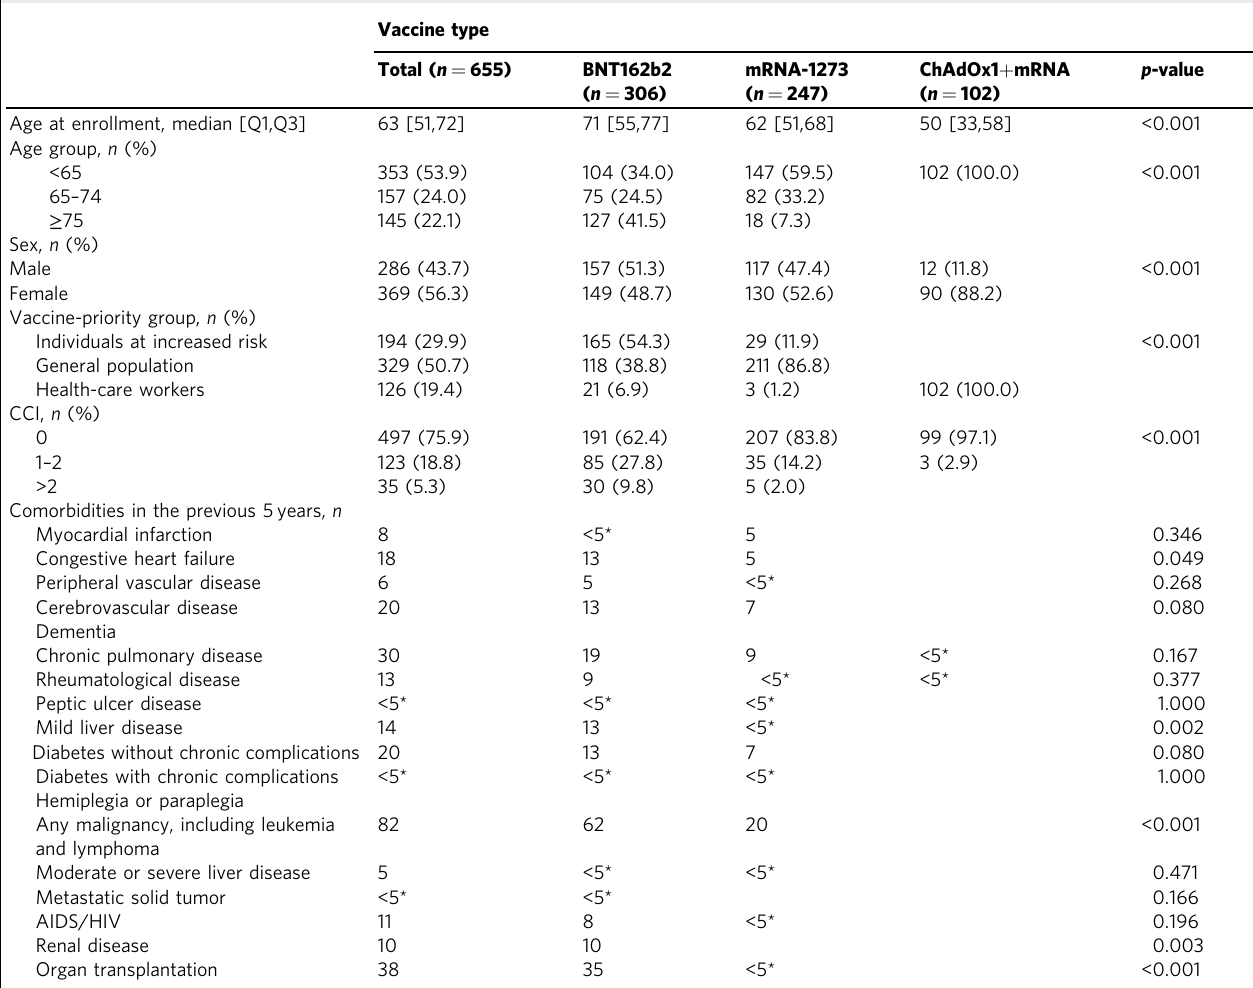
Table 1 Participant demographics at study enrollment by vaccine